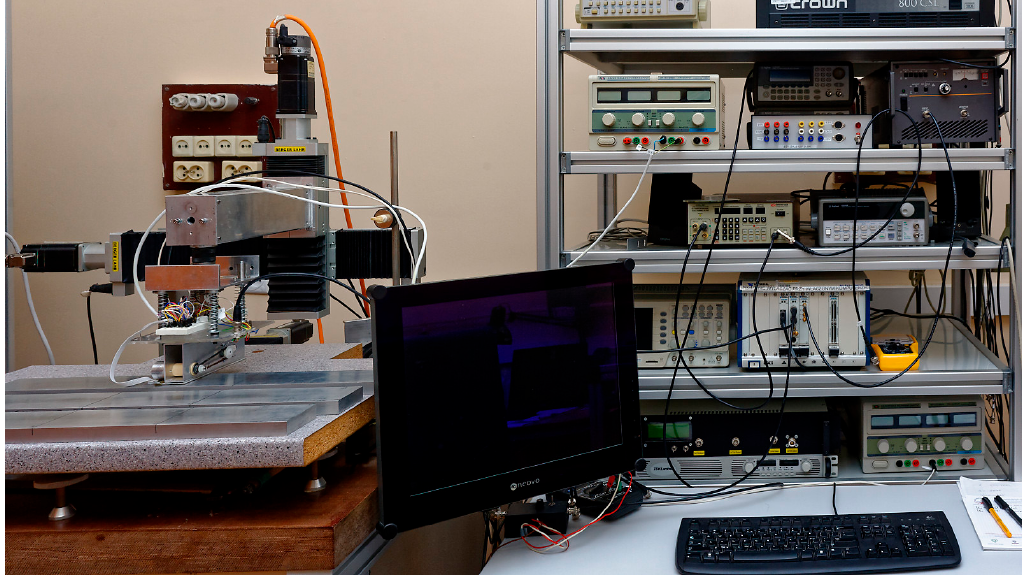
Figure 4. Photo of the experimental system and the aluminum test samples.